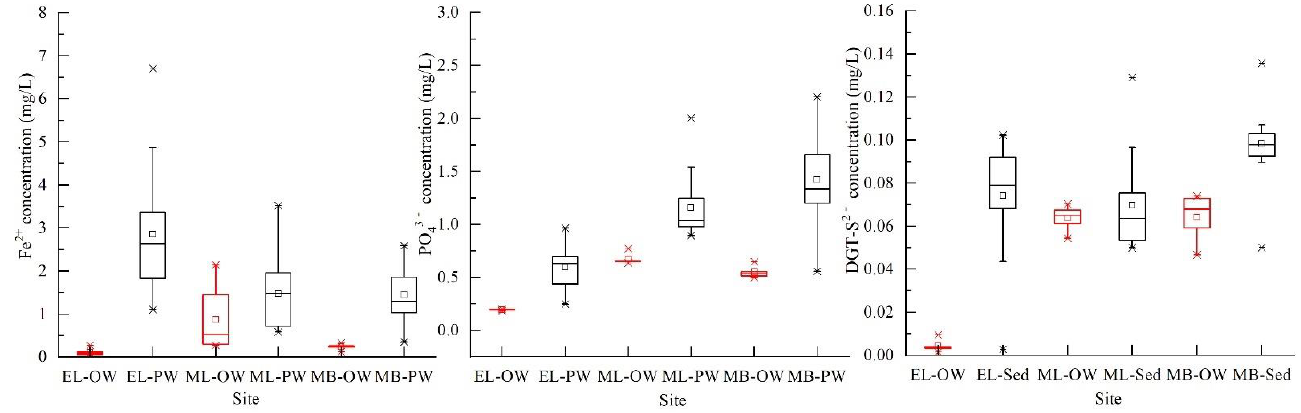
Figure 4. Concentrations of PO 43 − , Fe 2+ in pore water and DGT-S 2 − in sediments of Taihu Lake. OW represents overling water, PW represents pore water, EL represents the east of the lake, ML represents the middle of the lake, MB represents Meiliang Bay.